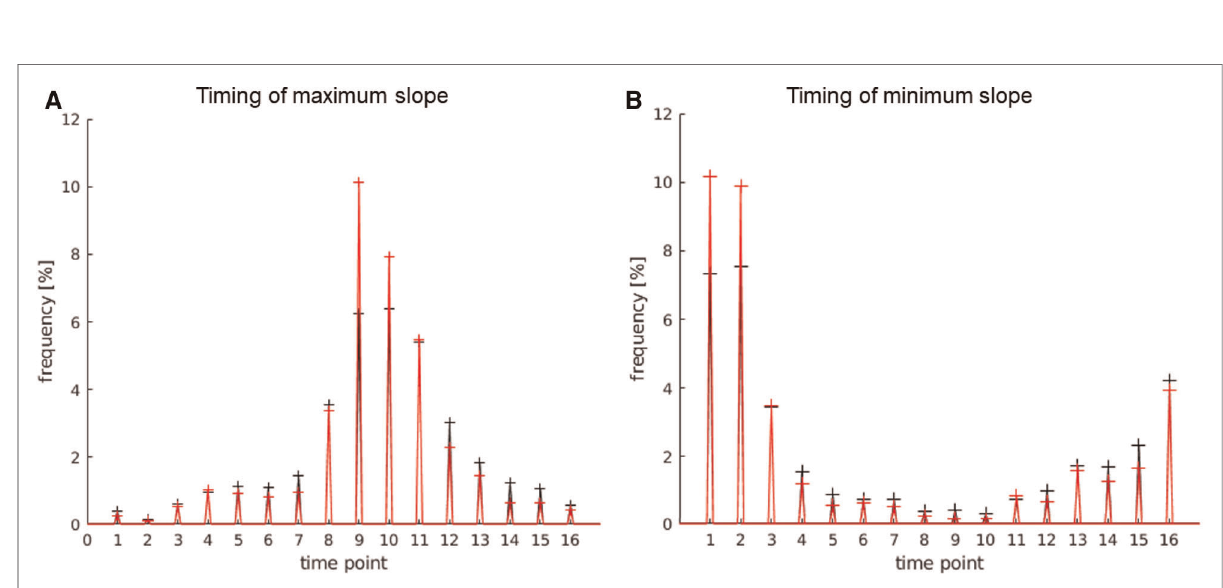
FIGURE 5 In this histogram, the maximum and minimum slope values of all activated voxels of the map (black) are compared to all activated voxels in the LAs (red for slope minimum; blue for slope maximum). For this analysis, all activation maps of the subject study were used. ( A ) This plot displays the frequency of activated voxels showing the slope maximum/minimum be-tween − 20 and 20%/s. ( B ) Magni fi cation of the plot in ( A ) ( − 5%/s – 5%/s) to better illustrate the frequency distribution in the lower max./min. slope ranges.